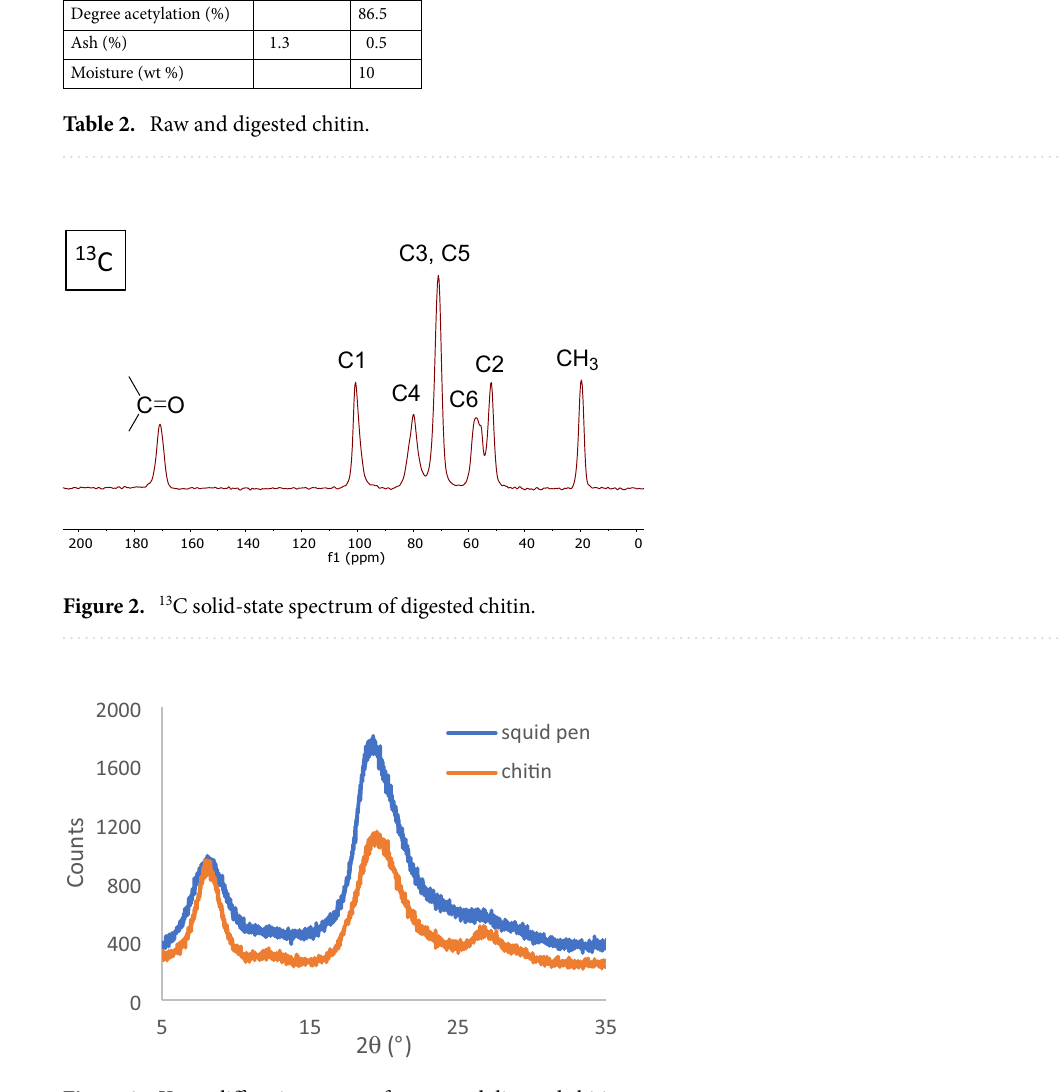
Figure 3. X-ray diffraction pattern for raw and digested